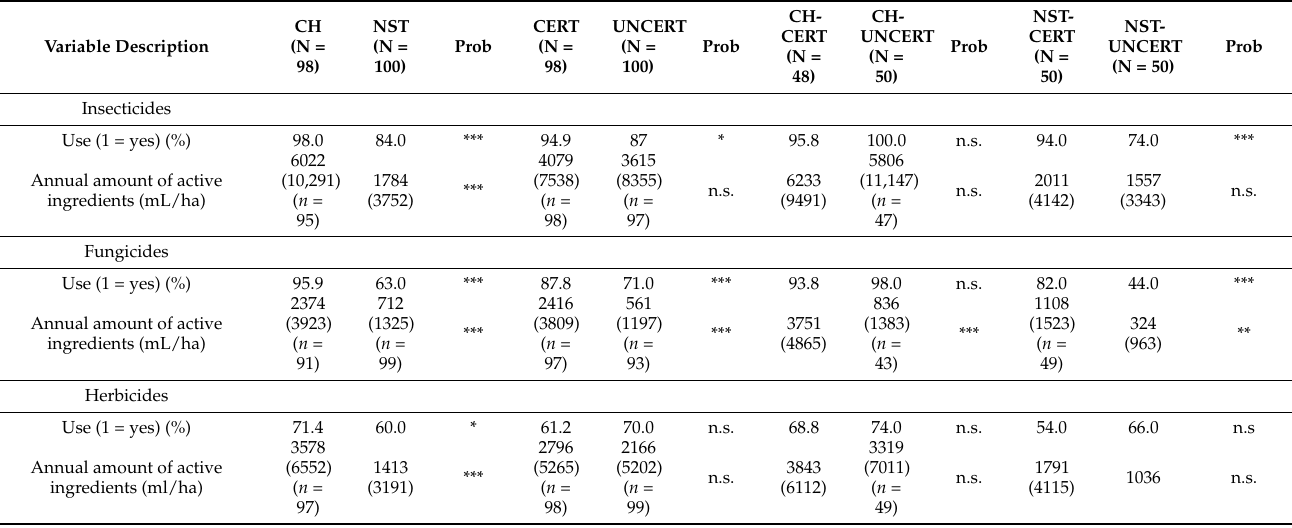
Table 8. Pesticide use by respondent